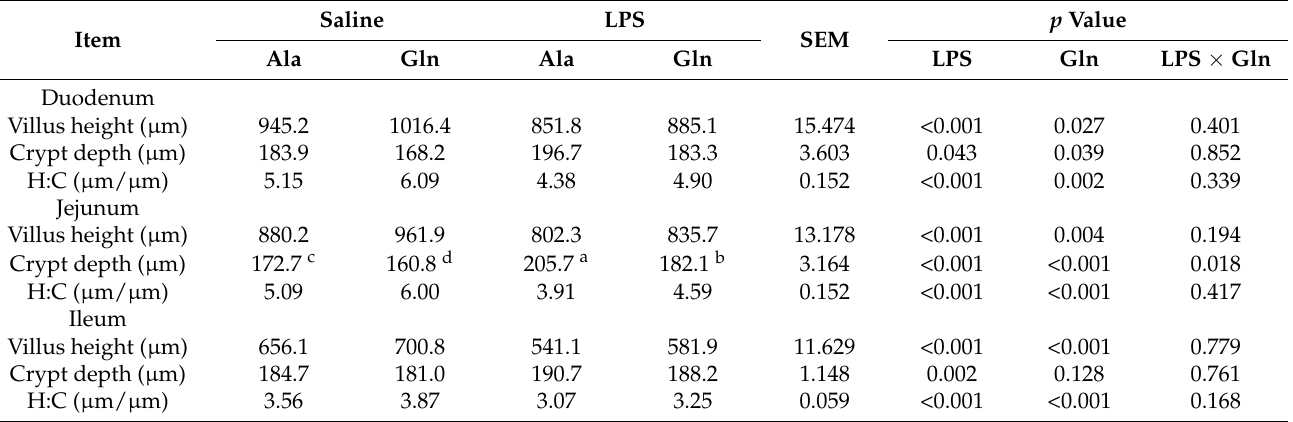
Table 4. Effects of dietary Gln supplementation on the small intestine morphology of broilers challenged with